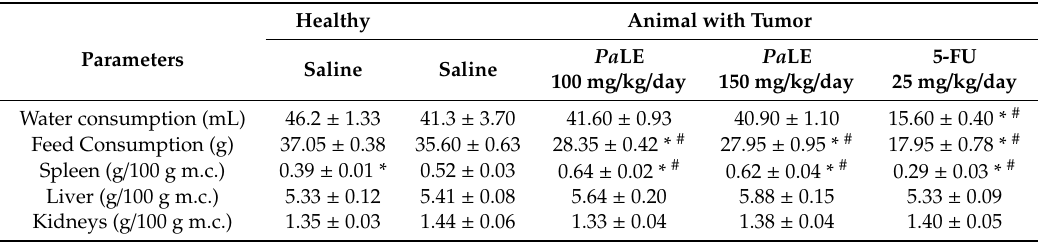
Table 3. E ff ect of Pa LE (i.p.) on the consumption of water, feed and organ mass of mice without and with S180 tumor.